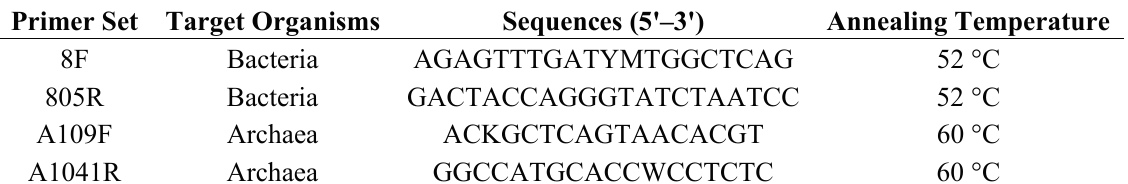
Table 3. Primer sets